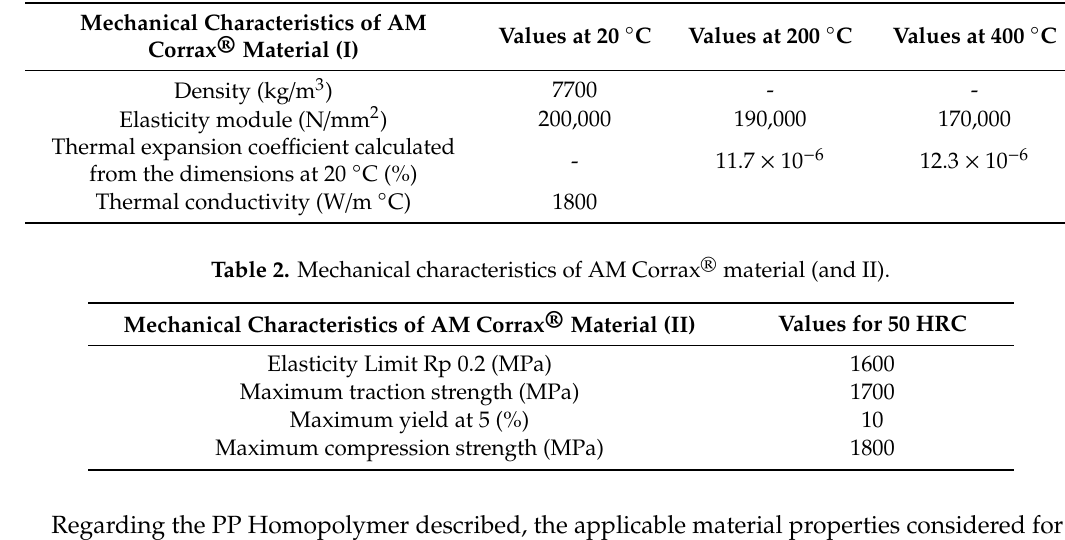
Table 1. Mechanical characteristics of AM Corrax ® material (I).